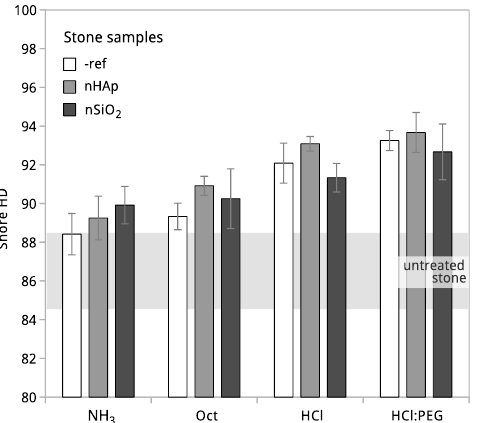
Figure 5. Shore D hardness of the stone surfaces after treatment with all prepared